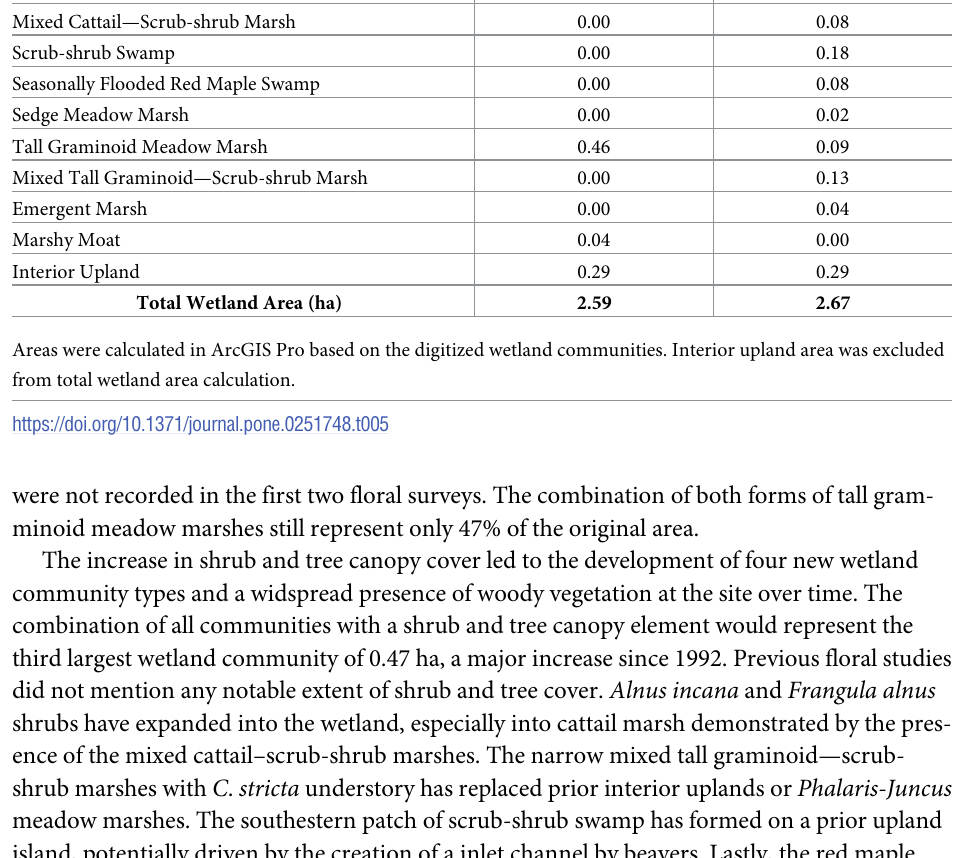
Table 5. Change in areas (ha) of wetland communities of Quarry Pond from 1992 to 2020. Community Type 1992 Area (ha) 2020 Area (ha) Aquatic Bed & Open Water 1.45 0.91 Cattail Marsh 0.64 1.15 Mixed Cattail—Scrub-shrub Marsh 0.00 0.08 Scrub-shrub Swamp 0.00 0.18 Seasonally Flooded Red Maple Swamp 0.00 0.00 Mixed Tall Graminoid—Scrub-shrub Marsh 0.00 0.13 Emergent Marsh 0.00 0.04 Marshy Moat 0.04 0.00 Interior Upland 0.29 0.29 Total Wetland Area (ha) 2.67 Areas were calculated in ArcGIS Pro based on the digitized wetland communities. Interior upland area was excluded from total wetland area calculation.